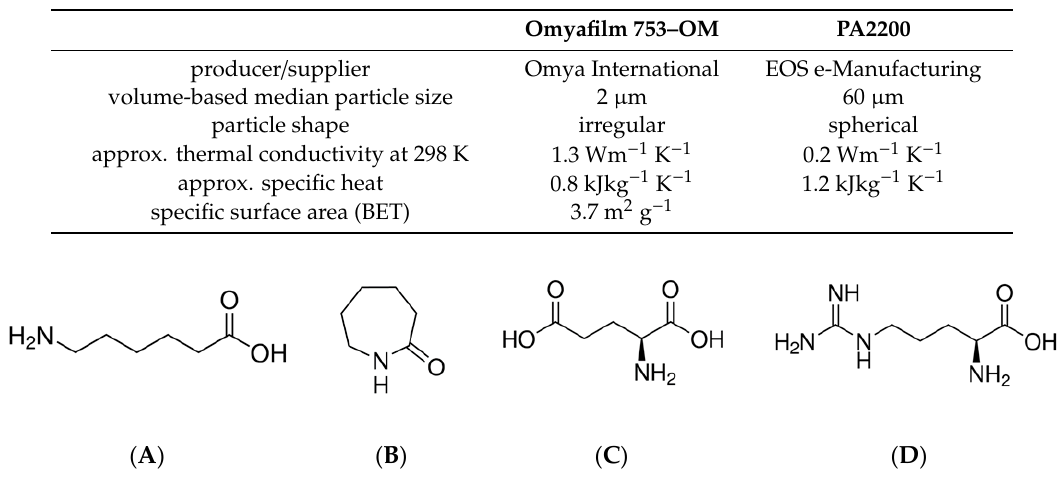
Table 1. Material specification.